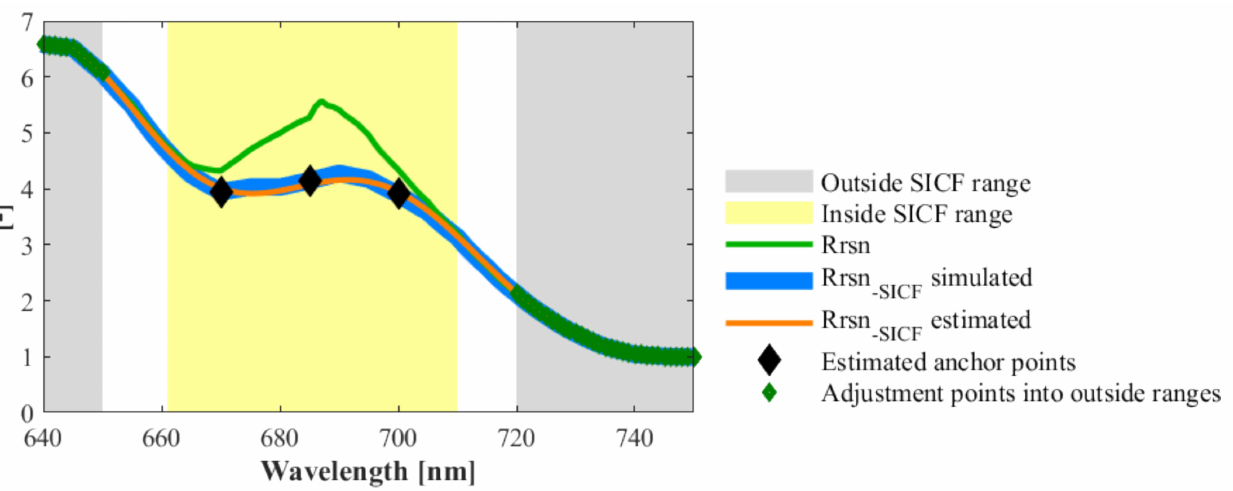
Figure 4. Graphic explanation of the Rrsn − SICF ( λ ) retrieval concept. The green spectrum corresponds to the “observed data” (from a radiometer or remote sensor) Rrsn ( λ ) . The black diamonds indicate the three anchor points estimated by using MLRA methods. The blue spectrum is the Rrsn − SICF ( λ ) “reference spectra” from the simulated training database and the orange spectrum is the Rrsn − SICF ( λ ) “estimated spectra” calculating the cubic spline fitting using the bands in the “outside ranges” (green diamonds) and the three anchor points. It is observed that Rrsn − SICF ( λ ) has a “shoulder” produced by the absorption/scattering effects from